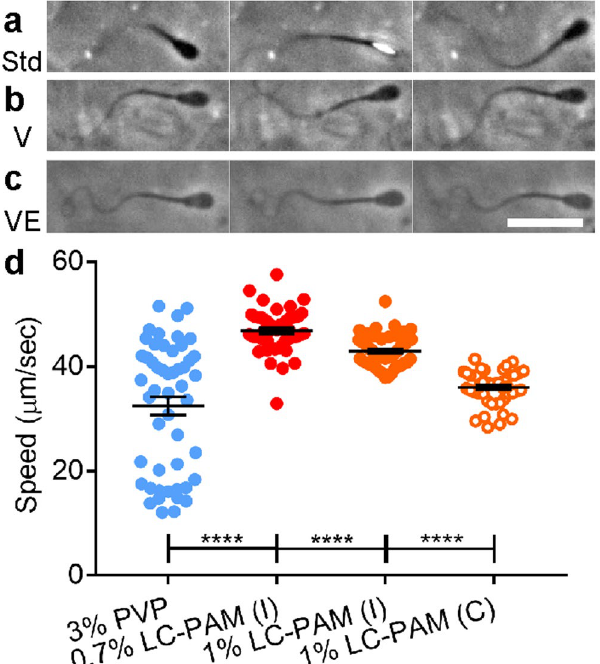
Figure 4. Influence of fluid rheology on sperm motility. ( a ) In standard medium, sperm exhibit near-surface swimming and rolling of the whole body, evidenced by alternating broad (black) and narrow (bright) surfaces of the head. ( b ) In a Newtonian viscous fluid (3% PVP), more than half of the sperm swam without rolling, and showed two-dimensional beating of the flagellum. Scale bar: 25 μ m. ( c ) In viscoelastic medium (1% LC- PAM), most sperm swam without rolling by using two-dimensional beating of the flagellum. ( d ) While 3% PVP is less viscous than the solutions of LC-PAM, sperm swam slower in it, indicating viscoelasticity allows sperm to swim faster. When we compared single sperm (1% PAM, orange filled circles) against those in clusters (orange open circles), it was found that sperm swimming in clusters had a lower mean speed. This is compared with 133 ± 2 µ m/s (mean ± s.e.m.) of single sperm in standard medium ( **** p < 0.0001, Mann-Whitney test, N = 50). Deborah numbers of individually swimming sperm in 0.7 and 1% LC-PAM are estimated to be 0.51 and 2.0